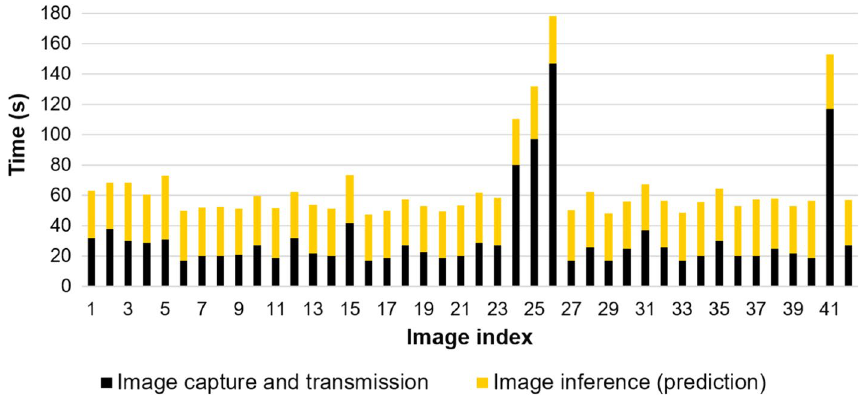
Fig. 14 Execution speeds for each test image from the pilot session conducted with the SEAT concept car (Mean: 65 s, Max: 178 s, Min: 47